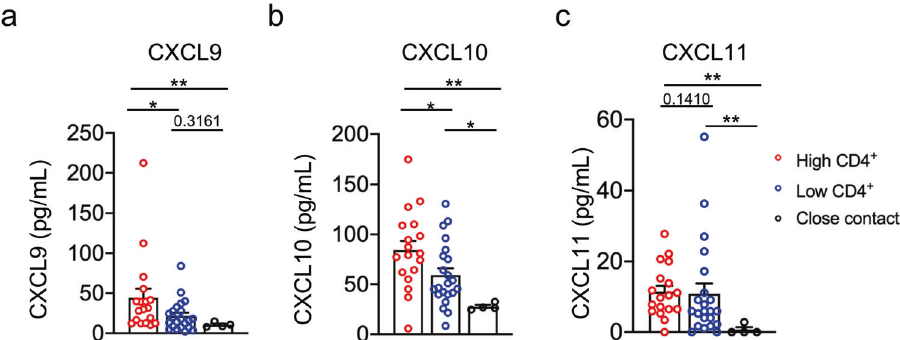
Fig. 4 Peripheral chemokines related to CD4 + T cells in convalescent patients with COVID-19. The levels of CXCL9, CXCL10, and CXCL11 were determined for high- ( n = 18) and low-CD4 + ( n = 22) convalescent individuals with COVID-19 and close contacts ( n = 4) at M2 using cytometric Beads array. a – c Dot plot analysis of ( a ) CXCL9, ( b ) CXCL10, and ( c ) CXCL11 levels among high-convalescent and low- CD4 + convalescent patients with COVID-19, and close contacts, respectively. Each dot represents an individual participant. Bars represent mean values. * p < 0.05 and ** p < 0.01. Student ’ s t -test was used to analyze differences in the mean values between groups. The Mann – Whitney test was used to compare the central tendencies of the two groups (mean or median). Data are presented as mean ±